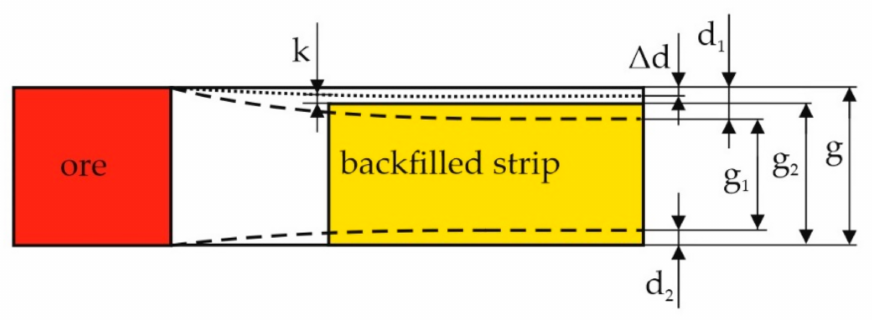
Figure 15. Compressibility scheme of the backfill.